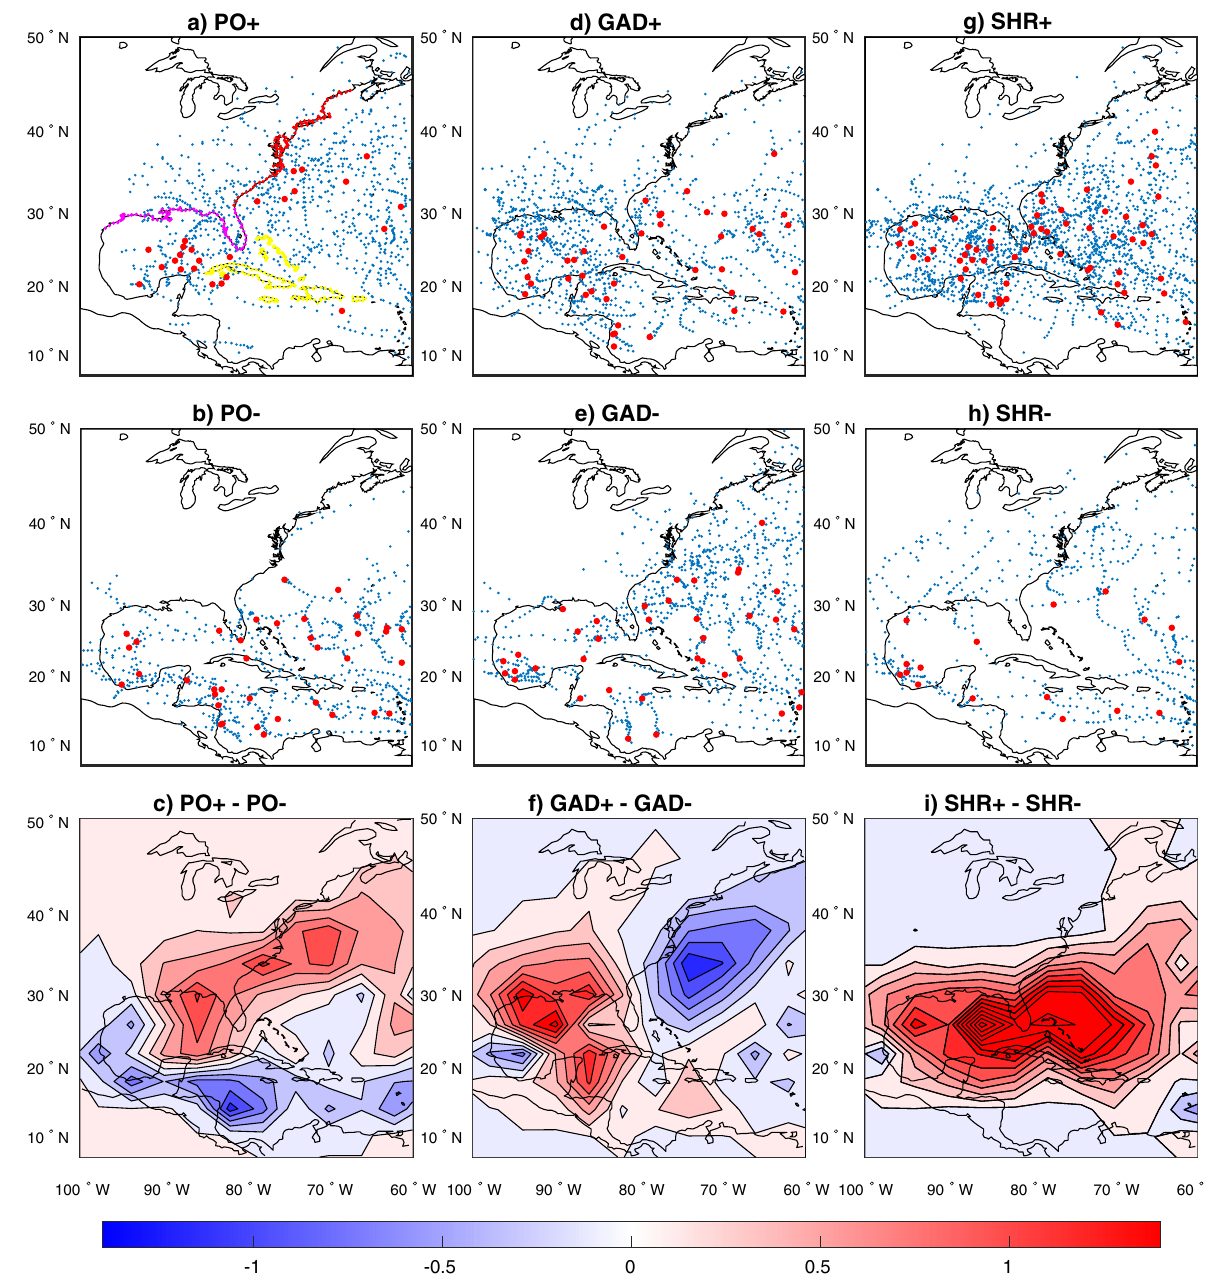
Fig. 3 Modulation of tropical cyclone (TC) activity by three subseasonal modes. a , b the TC positions (every 6 h) including their geneses (red dots) during the strong positive (normalized PC > 1) and negative (normalized PC < − 1) phases of EOF1 modes derived from the band- pass fi ltered (10 – 35 days) H850 anomalies. c the TSDs (per 100 days) difference between the strong positive and negative phases of EOF modes. The right two columns are similar to the left column but for EOF2 ( d – f ) and EOF3 ( g – i ) modes, respectively. The magenta, red, and yellow coastal lines in a) represent the individual landfalling regions: Gulf Coast, East Coast, and the Caribbean,